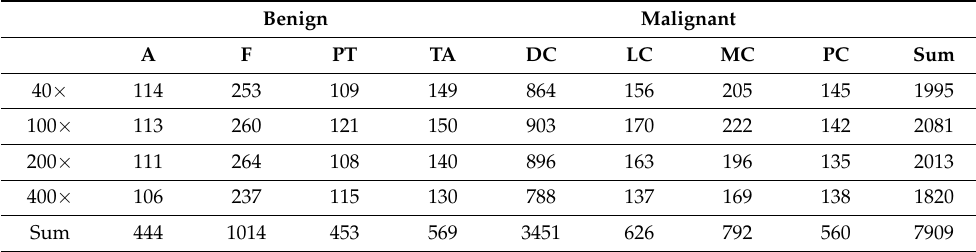
Table 2. Distribution of data in BreakHis dataset. Benign